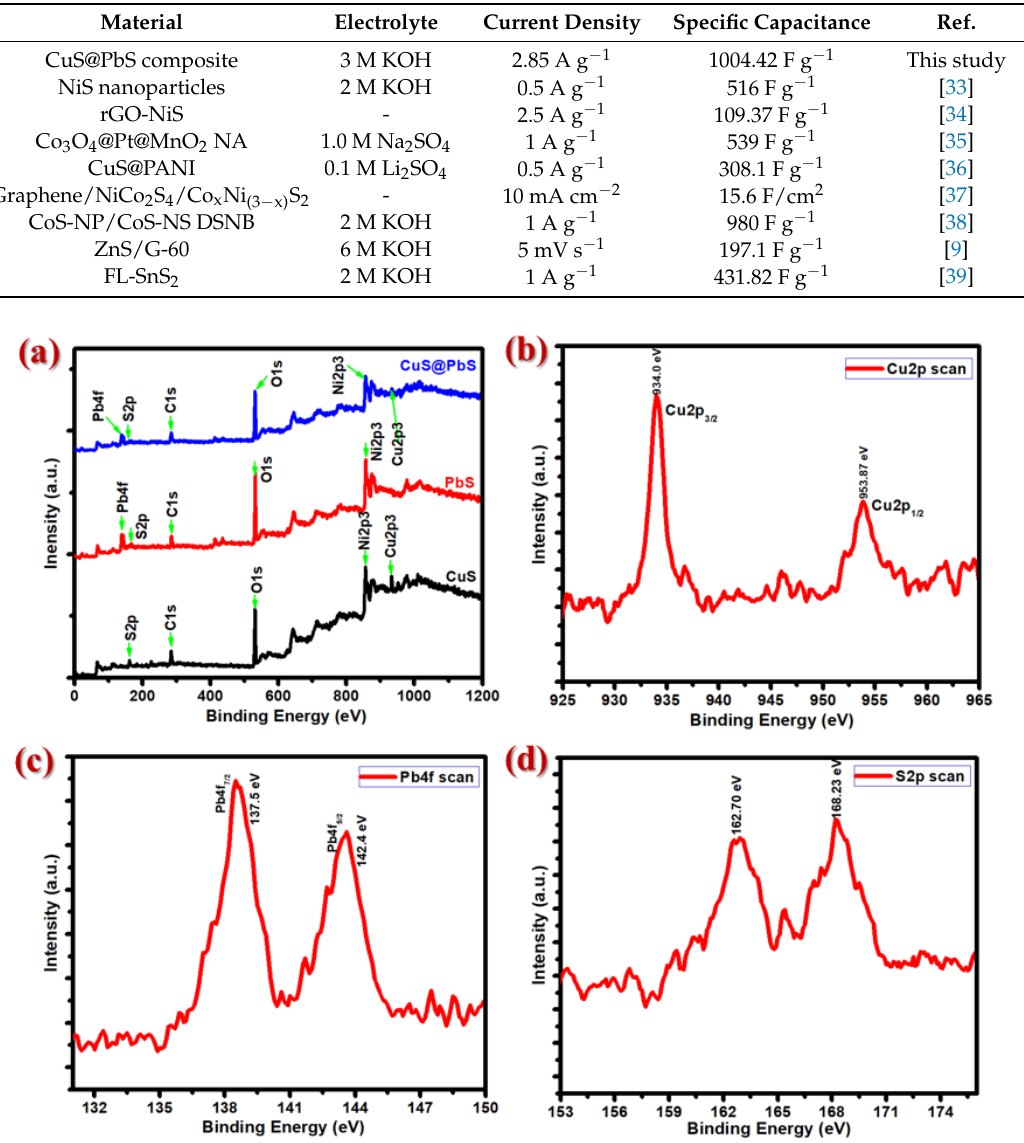
Table 1. Comparison of specific capacitance of CuS@PbS composite with different electrodes.